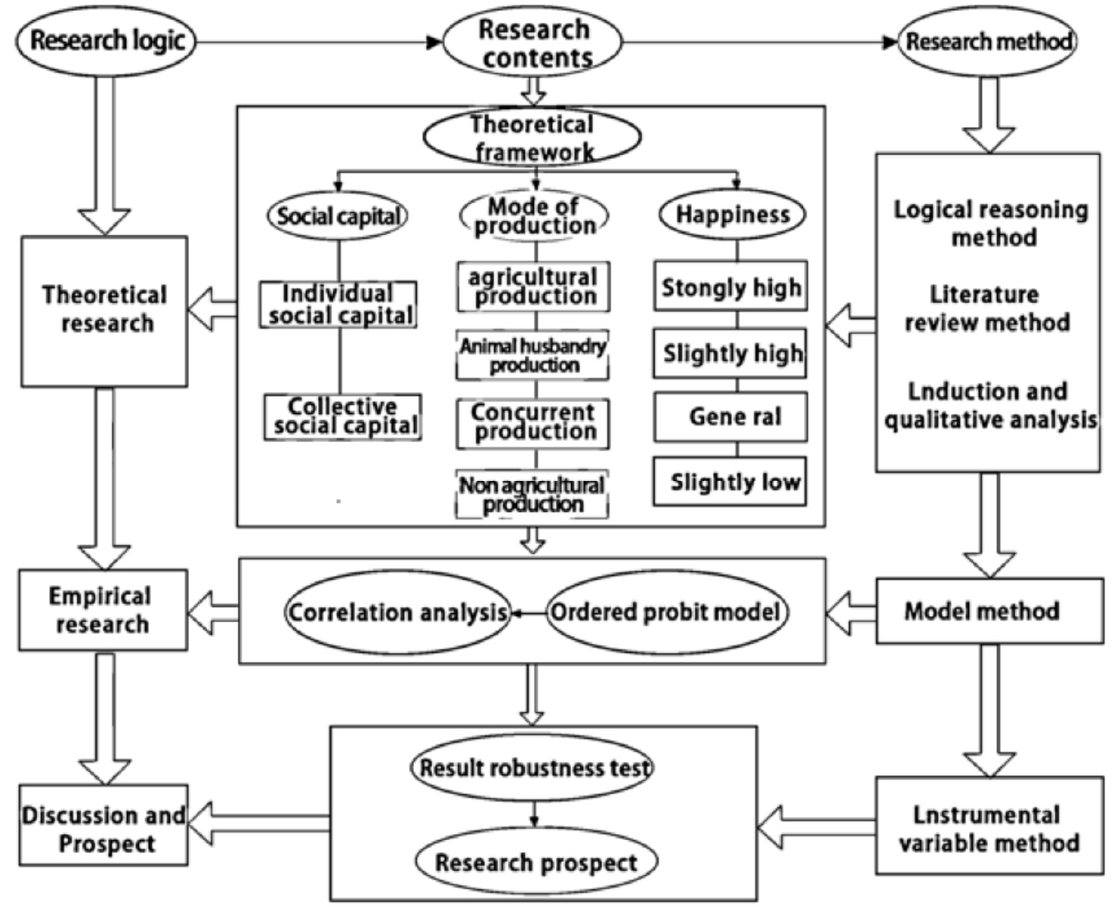
Figure 1. Research Figure 1. Research framework.